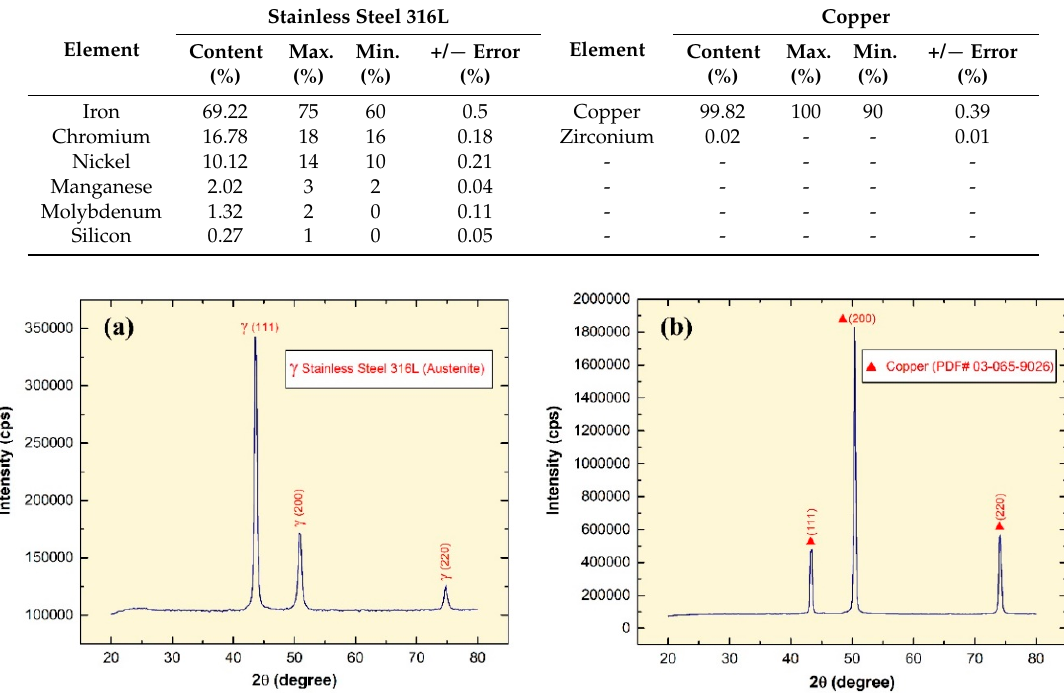
Figure 2. X-ray diffraction pattern of: ( a ) SS 316L substrate, and ( b ) Cu substrate.